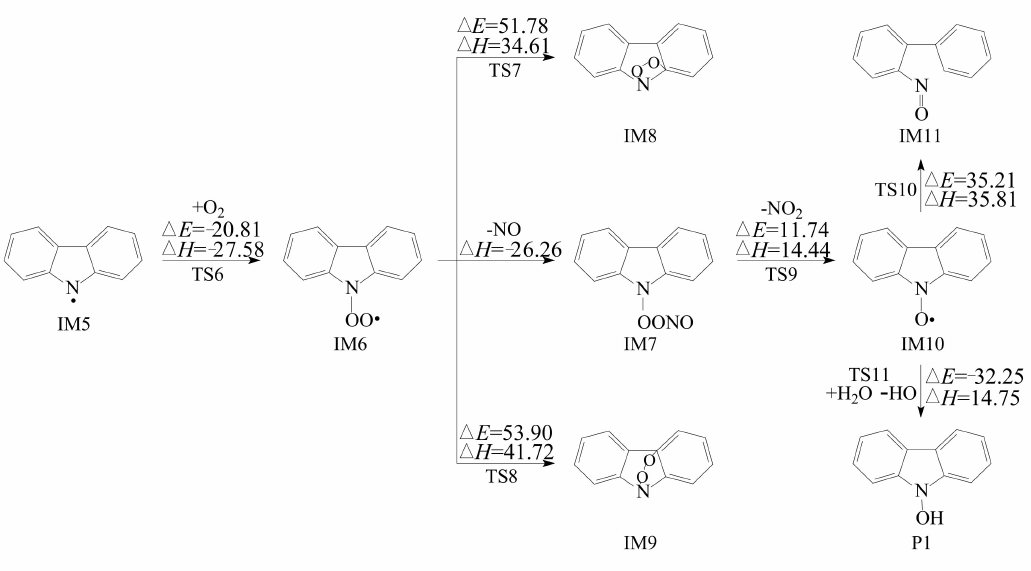
Figure 4. The reaction scheme of IM5 is embedded with the potential barriers ∆ E (in kcal mol − 1 ) and the reaction heats ∆ H (in kcal mol − 1 , 0 K) in the presence of NO and O 2